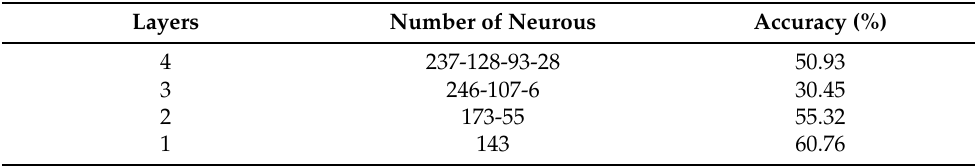
Table 3. Performance of different MLP structures on the AVLetters dataset.